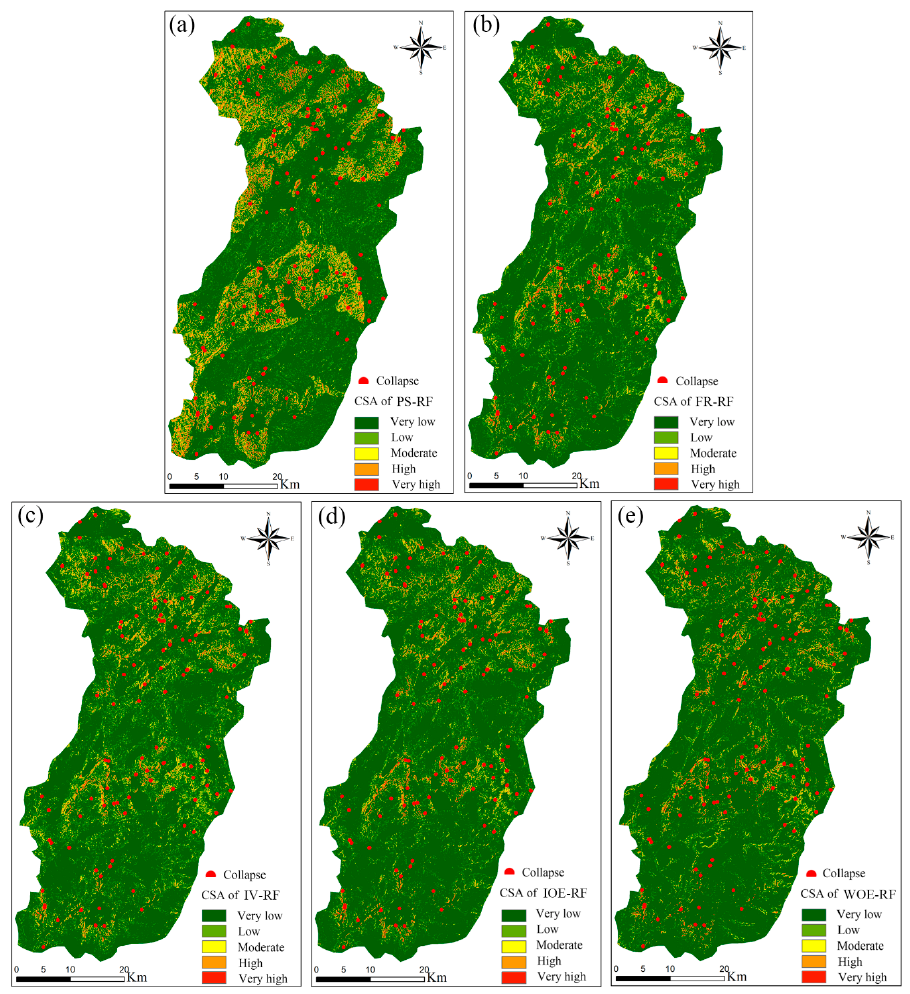
Figure 8. Collapse susceptibility maps of ( a ) Probability Statistics (PSs)-RF, ( b ) Frequency Ratio (FR)- RF, ( c ) Information Value (IV)-RF, ( d ) Index of Entropy (IOE)-RF and ( e ) WOE-RF. ( c ) Information Value (IV)-RF, ( d ) Index of Entropy (IOE)-RF and ( e )